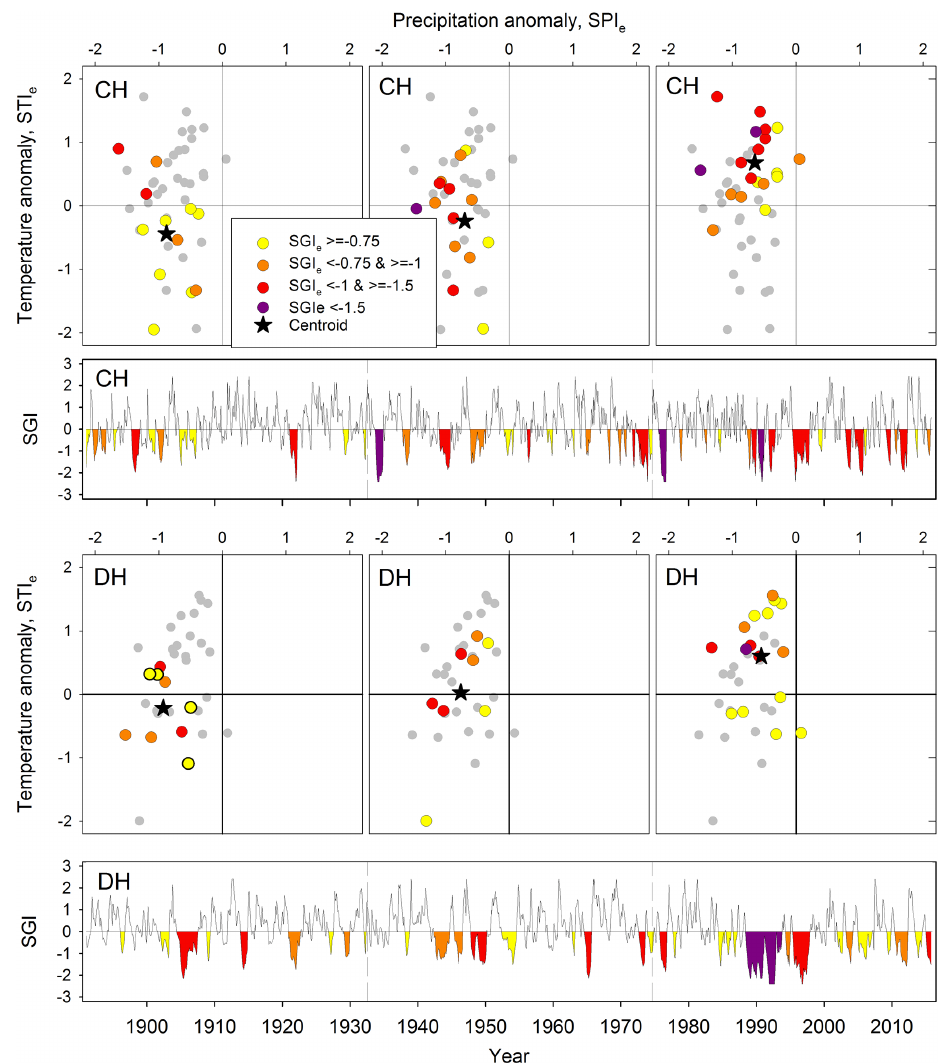
Figure 5. Changes in the incidence and magnitude of episodes of groundwater drought since 1891 as a function of temperature and pre- cipitation. Mean groundwater drought event intensity (mean SGIe) as a function of mean event SPI and STI for the periods 1891–1932, 1933–1943 and 1944–2015. Grey symbols indicate all episodes of groundwater drought at a site. Yellow through to purple symbols indicate increasing mean SGI for the episodes of groundwater drought. The black star denotes the centroid of the episodes of SGI in each third of the observational record. The SGI time series are shown below the cross plots for reference with SGI drought events of a given magnitude highlighted. Data for CH are shown in the upper panels and DH in the lower